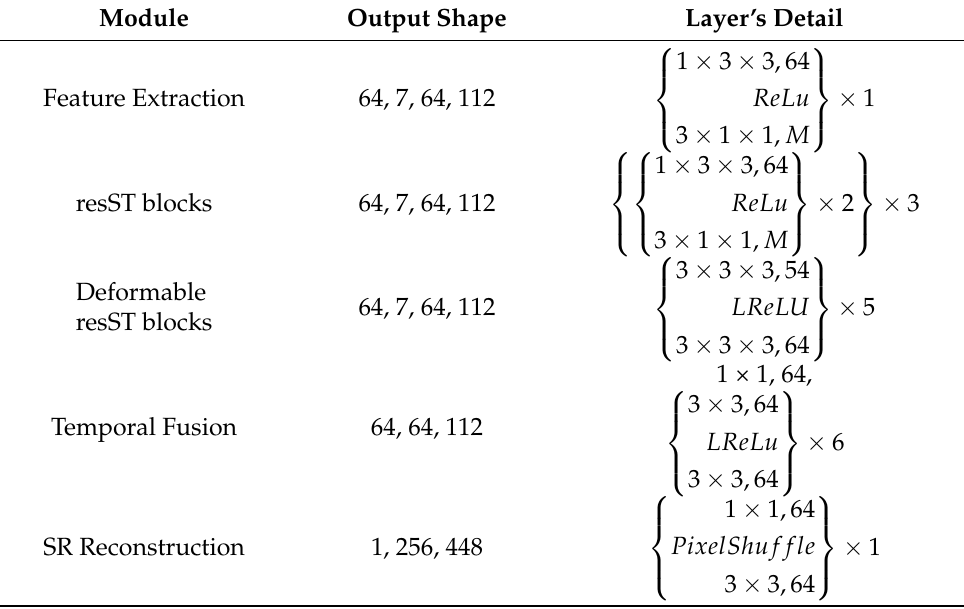
Table 1. Detail of DSTnet architectures considered in experiments. Output shape dimension are batch size, channel, height, and width. Layers details is formatted as: filter shape, number of filters. The spatio-temporal convolutional blocks are shown in brackets, by the number of times these are repeated in each resST blocks.